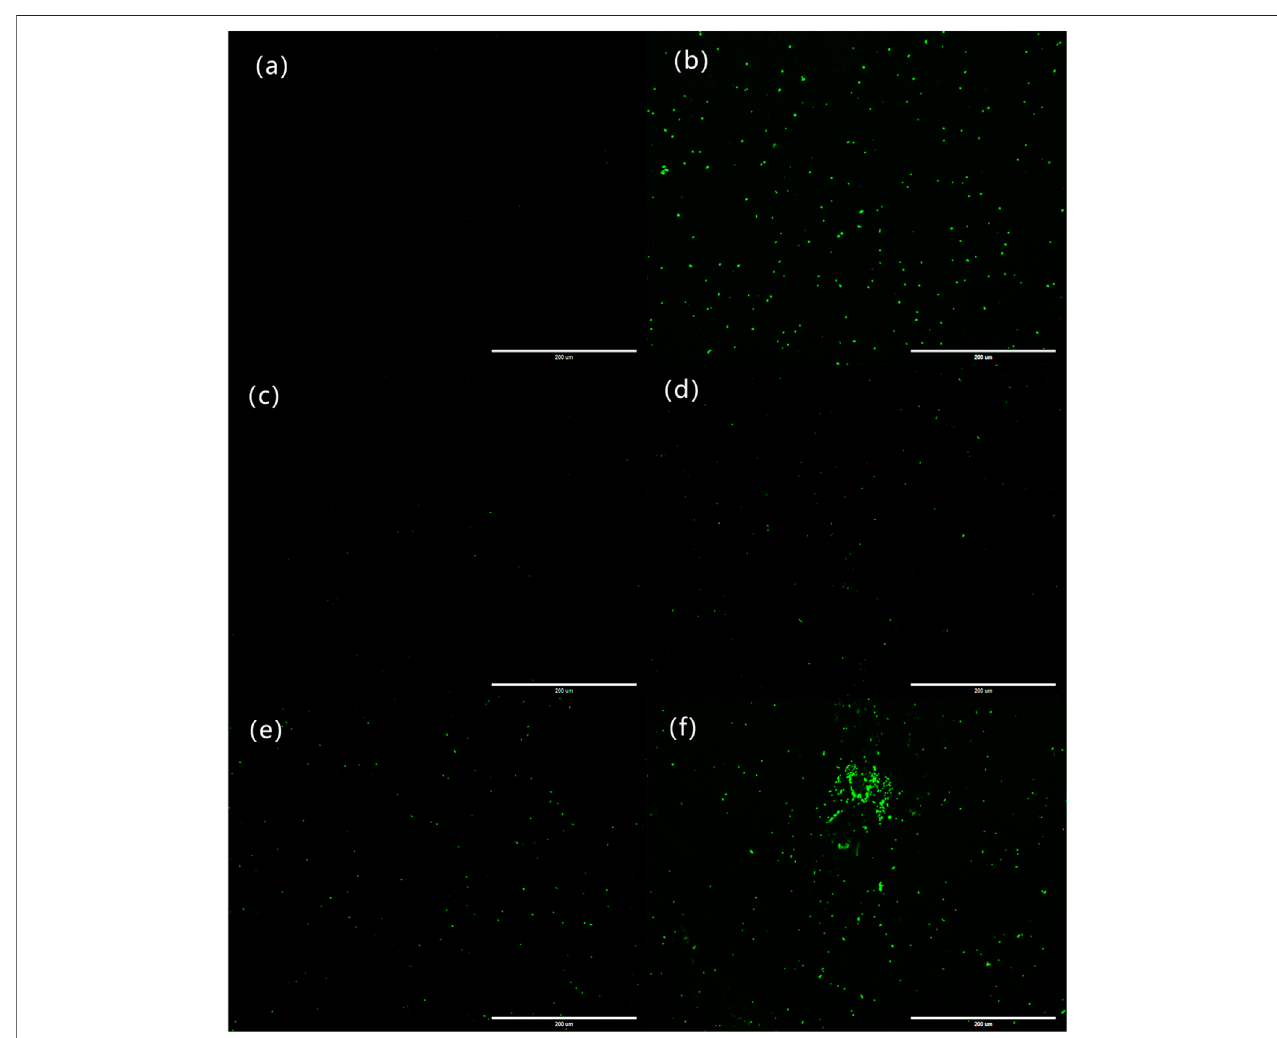
FIGURE9| LaserconfocalmicroscopytoobservetheeffectofLY@ZnOonROSinbacteria. (A) 0.0 mg/LLY@ZnO; (B) 20.0 mg/Lgentamycin; (C) 20.0 mg/LLY; (D) 20.0 mg/L ZnO; (E) 5.0 mg/L LY@ZnO; and (F) 20.0 mg/L LY@ZnO.